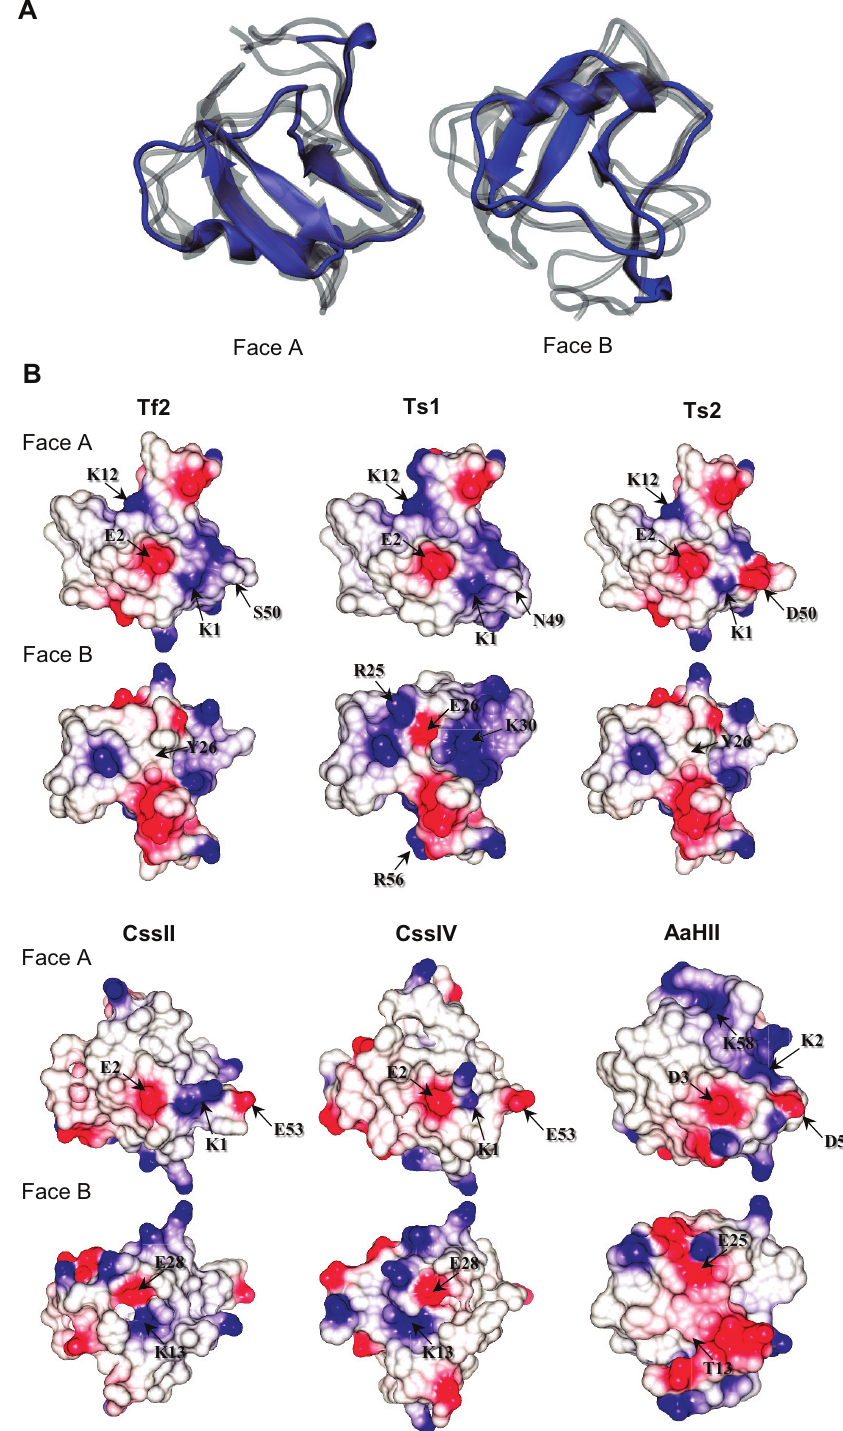
Fig 3. Structural comparison between Tf2 and other Na v channel toxins. (A) Structural alignment between Tf2 (in blue) and five other Na v channel scorpion toxins — Ts1, Ts2, CssII, CssIV, and AaHII (in gray). (B) Comparison of electrostatic potentials between the toxins Tf2, Ts1, Ts2, CssII, CssIV, and AaHII. The figure shows charge distribution along the toxin surface, divided into faces A and B. Shown in red are acidic residues whereas blue represents basic residues; in white, neutral regions are